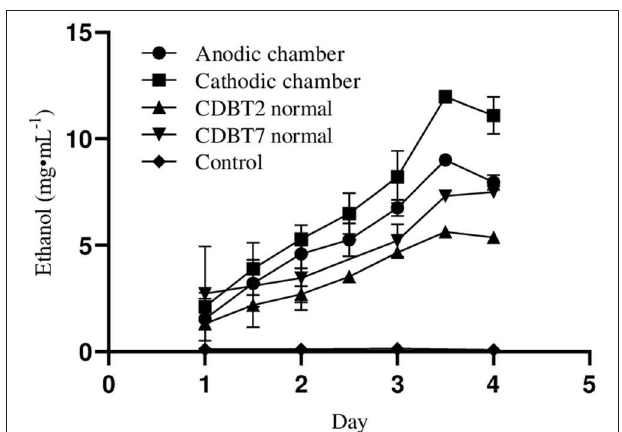
FIGURE 6 | Ethanol production from lignocellulosic hydrolysate ( S. spontaneum pretreated with hot water for 2h followed by 0.5M acid hydrolysis) in ECC with CDBT2 and CDBT7 strains cultured in anodic and cathodic compartments, respectively (Control: ECC without yeast culture and without external voltage supply. Normal: ECC with yeast culture and without external voltage